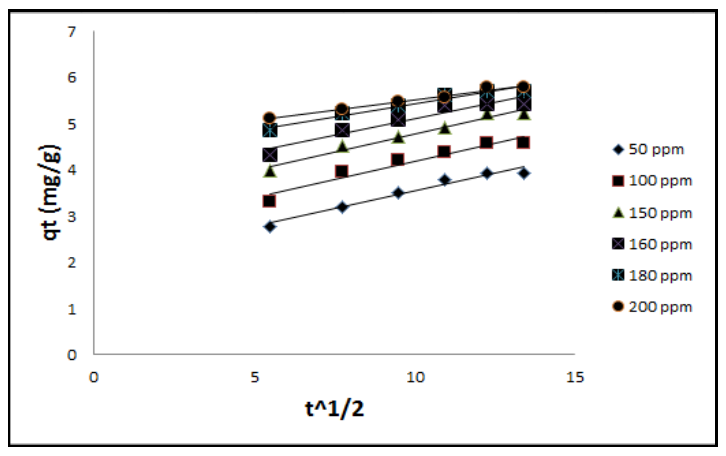
Fig. 13. intrapartical diffusion kinetic modal for methyl orange for concentration range (50−200 ppm) at 20 °C.